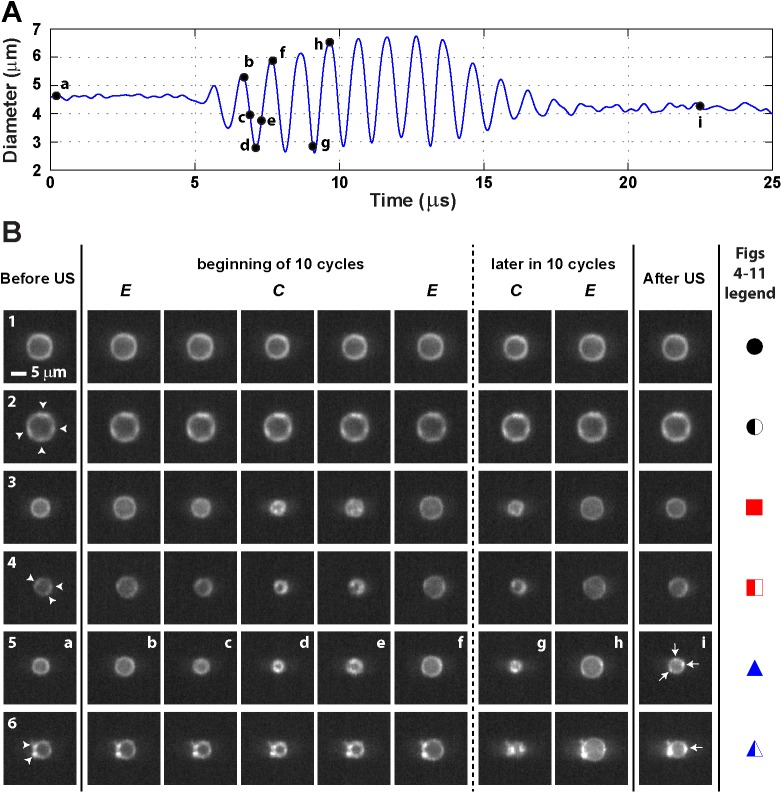
Microbubble vibration during insonification at a frequency of 1 MHz and P_ of 50 kPa.(A) D-t curve of the microbubble shown in 2B5; the letters correspond to the frames shown in 2B5. (B) Typical examples of lipid coating behavior during insonification. Arrow heads in leftmost column indicate hot spots present before insonification; arrows in second column to right indicate hot spots formed during insonification that persisted when the ultrasound was off; see S1–S6 Videos for the ultra-high-speed recordings of the shown selected frames. US = ultrasound; E = expansion phase; C = compression phase. The symbols in the rightmost column (see Fig 3 for more details) are the figure legends for Figs 4–10.